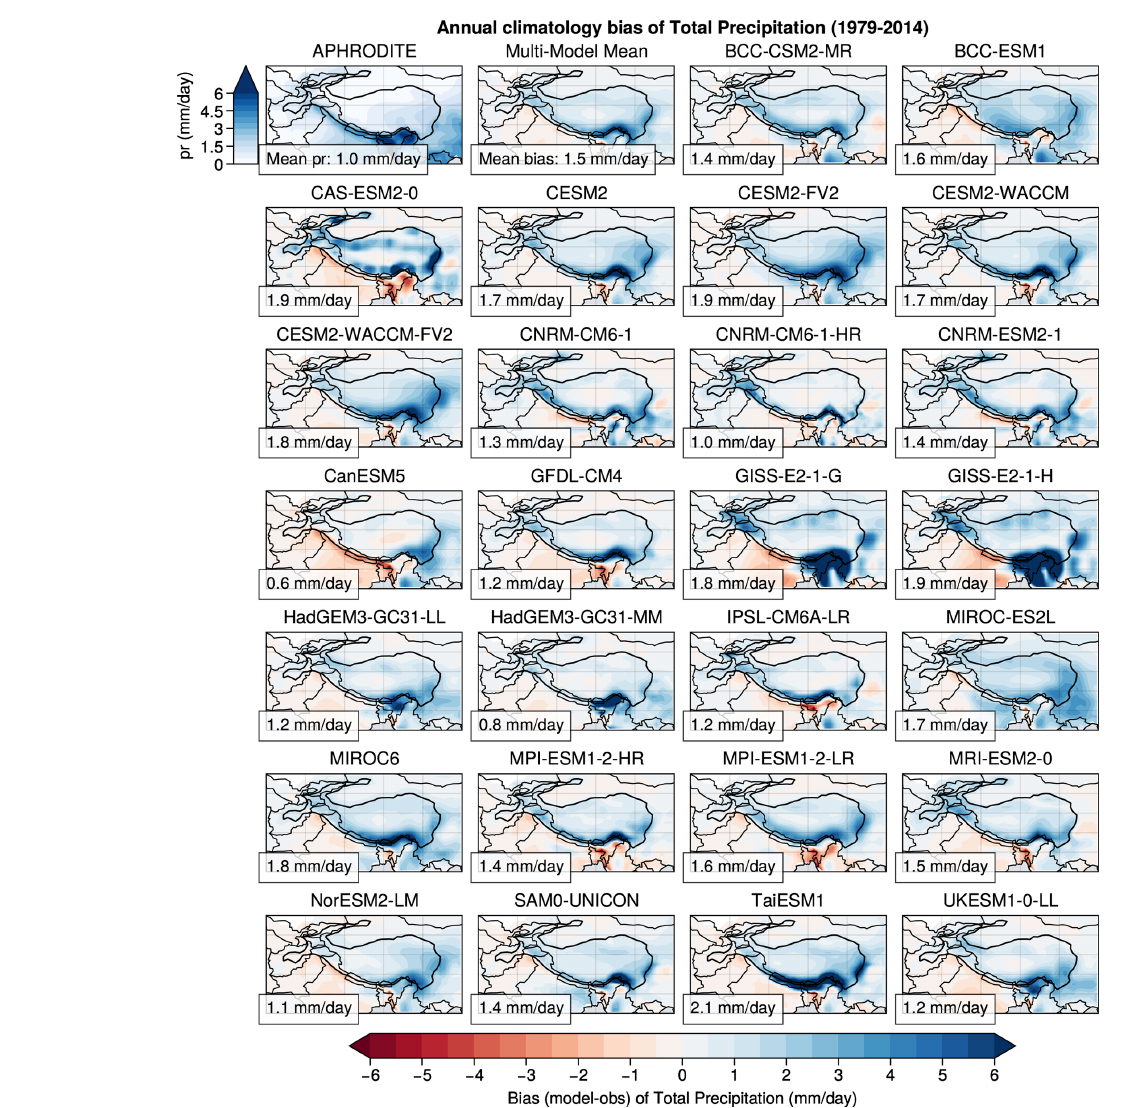
Figure B2. Same as Fig. 3 but for total